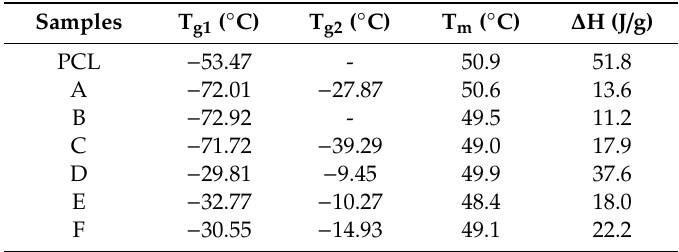
Table 3. Glass transition temperatures (T g ), melting temperature (T m ), and heat of fusion ( ∆ H) for PCL, A = STR5L / PCL at 40 / 60, B = STR5L / PCL at 50 / 50, C = STR5L / PCL at 60 / 40, D = ENR-50 / PCL at 40 / 60,